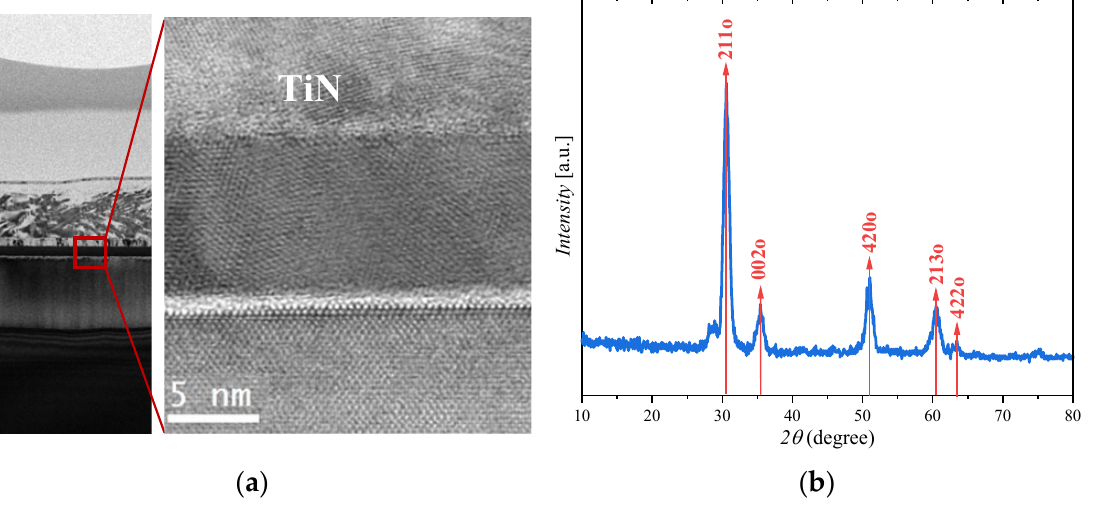
Figure 2. ( a ) Cross-sectional transmission electron microscope (TEM) image of the FeFET with gate stack of TiN/HZO/SiO 2 on Si substrate. ( b ) The X-ray diffraction (XRD) pattern of the HZO thin films.